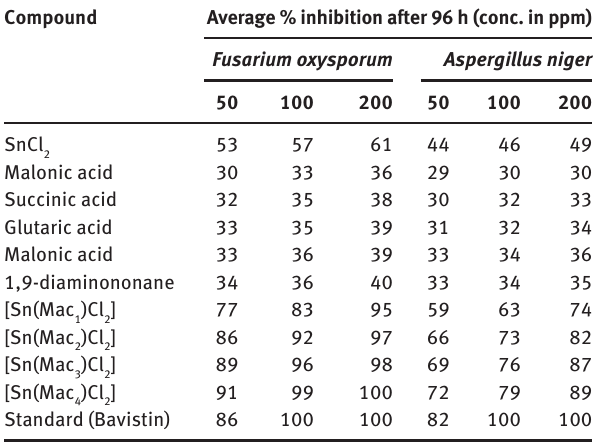
Table 3 1 H NMR spectral data (ppm) of tin(II) macrocyclic complexes.